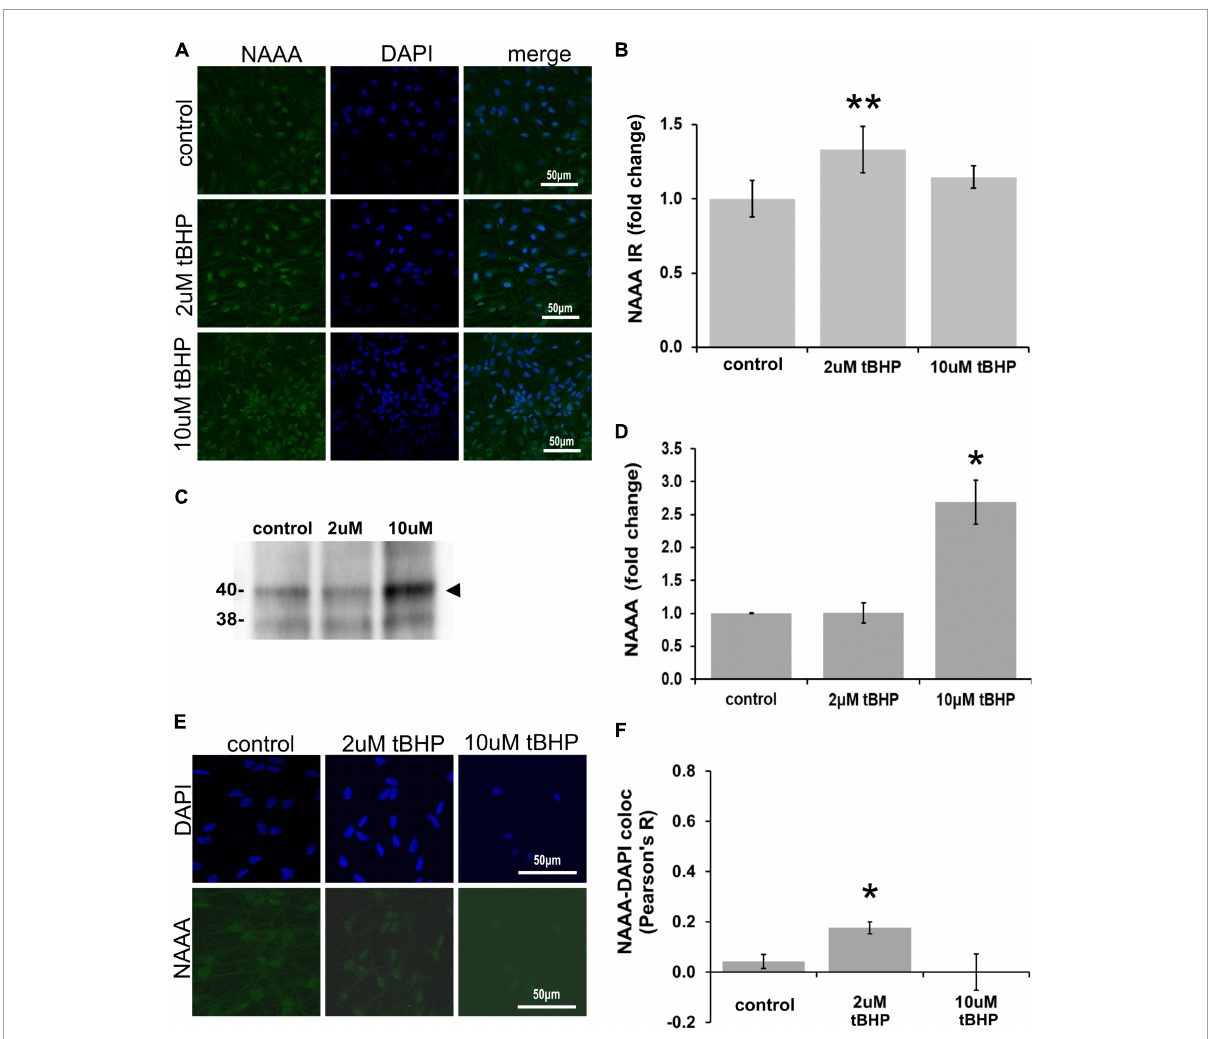
FIGURE5 Expression of N -acylethanolamine acid amidase (NAAA) in ReN cells under conditions of oxidative stress. (A) ReN cells express NAAA in the soma, including in the nuclear envelop and possibly in the nucleus, as well as neurites. (B) Exposure of ReN cells to sublethal concentration of tert-butylhydroperoxide (tBHP) resulted in a biphasic NAAA expression pattern–2 µ M tbHP led to a 35% increase in NAAA immunoreactivity while 10 µ M did not, although a trend toward an increase existed. Green fluorescence is NAAA and blue fluorescence is DAPI. (C,D) Western blot analysis reveals that the expression of a 40-kDa band (expected molecular weight is 40 kDa) corresponding to NAAA is upregulated 2.6-fold by exposure to 10 µ M tBHP by. (E,F) Colocalization analysis between NAAA immunoreactivity with DAPI fluorescence (DNA) reveals no significant colocalization at resting untreated conditions, but 2 µ M tBHP exposure led to a slight increase in Pearson’s R (from 0.03 to 0.20). Higher tBHP concentrations (10 µ M) had no effect on NAAA-DAPI colocalization. * p ≤ 0.05, ** p ≤